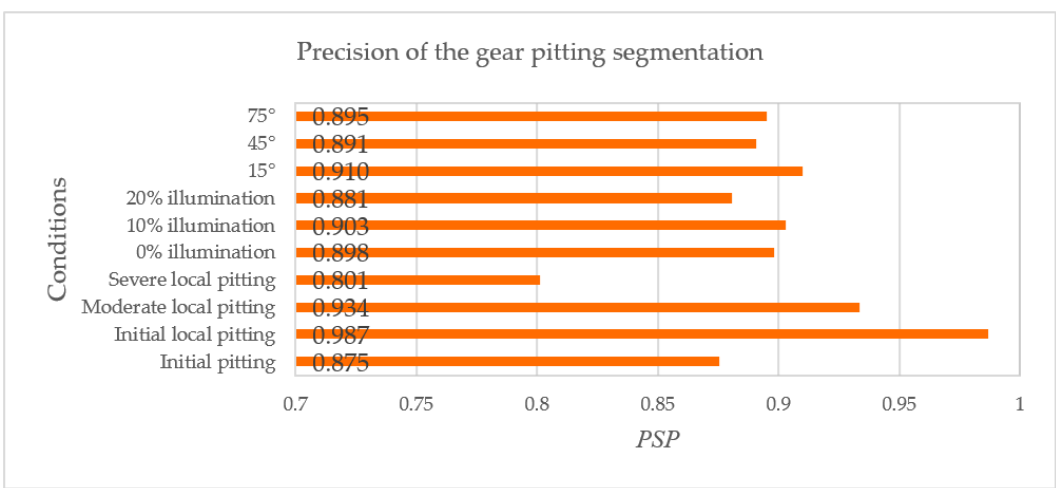
Figure 15. Precision of the gear pitting segmentation.